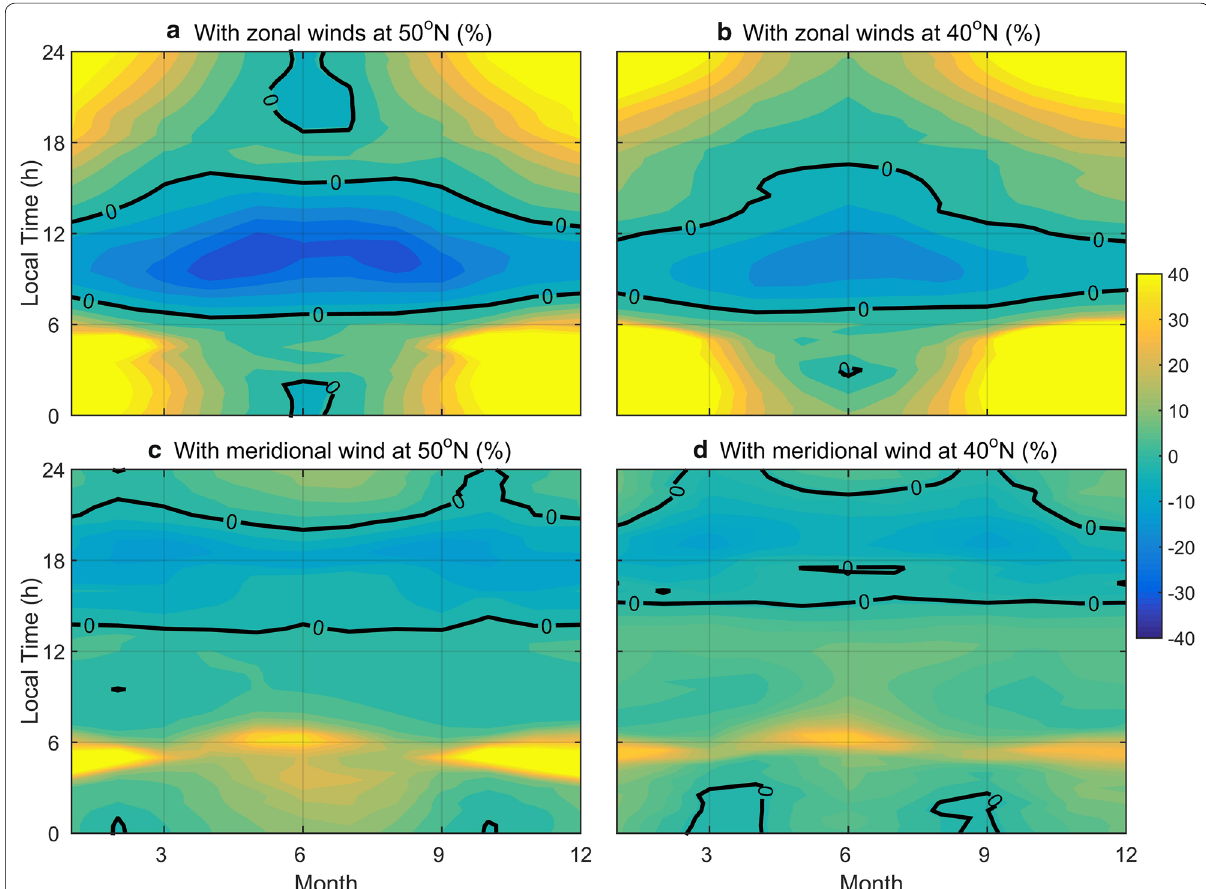
Fig. 7 The seasonal and diurnal variations of R ew (in units of %) driven by a , b thermospheric zonal wind and by c , d thermospheric meridional wind. The left and right plots, respectively, show the east–west differences a , c at 50º N and b , d at 40º N. The solid lines in these plots represent the zero